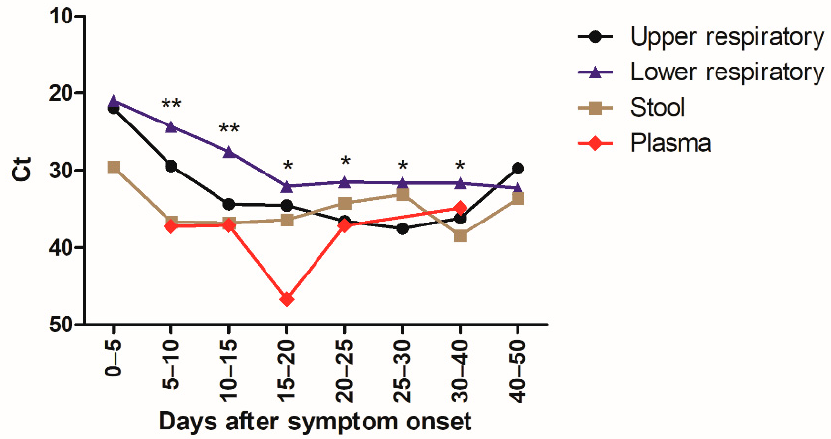
Figure 3. Kinetics of SARS-CoV-2 virus load as a function of time after symptom onset.